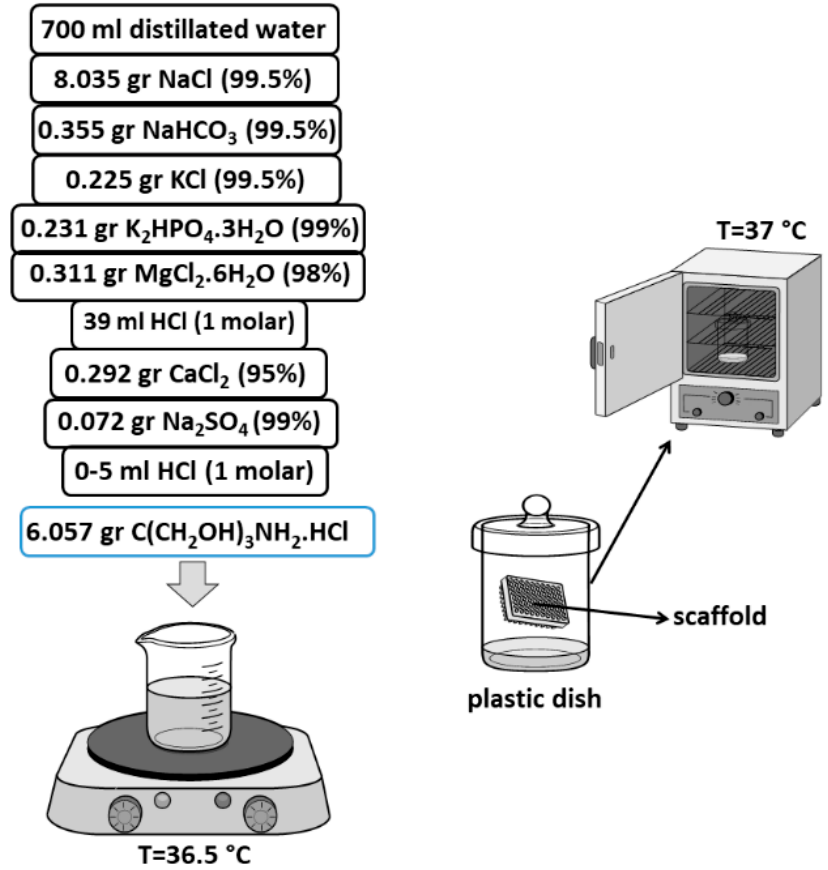
Figure 13. Synthesis of SBF [29], immersed scaffold in the SBF at 37 °C.